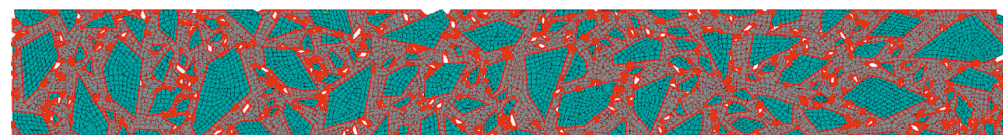
Figure 6: Final FEM modelling for the asphalt